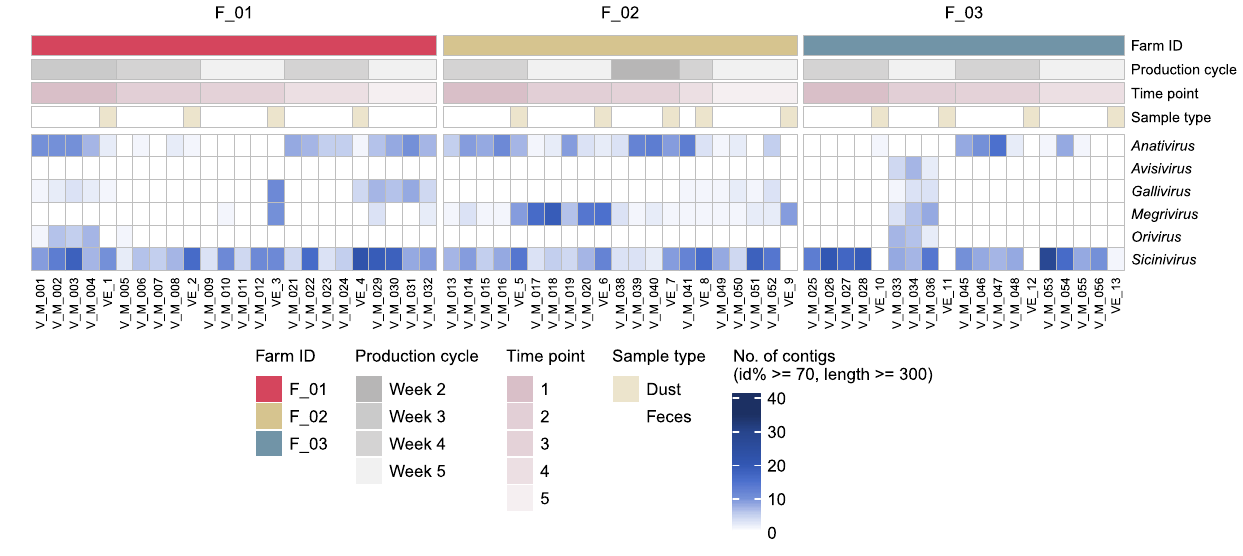
Figure 3. An overview of picornavirus contigs detected in chicken feces and chicken farm dust samples. Each column represents one sample. Associated metadata is shown at the top panel. The color intensity of the heatmap (bottom panel) is determined by number of contigs with minimum length of 300 nt, at least 70% identity and an e-value threshold of 1 × 10 –10 when comparing with closest reference in our database.